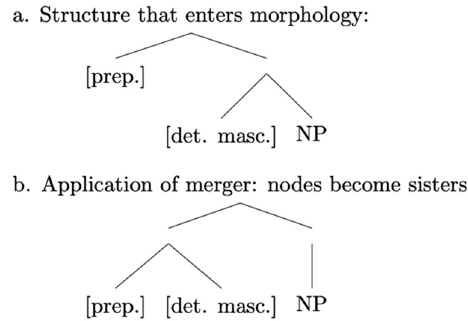
Figure 1. Two operations behind contractions in Portuguese (Ximenes 2004, p. 182).